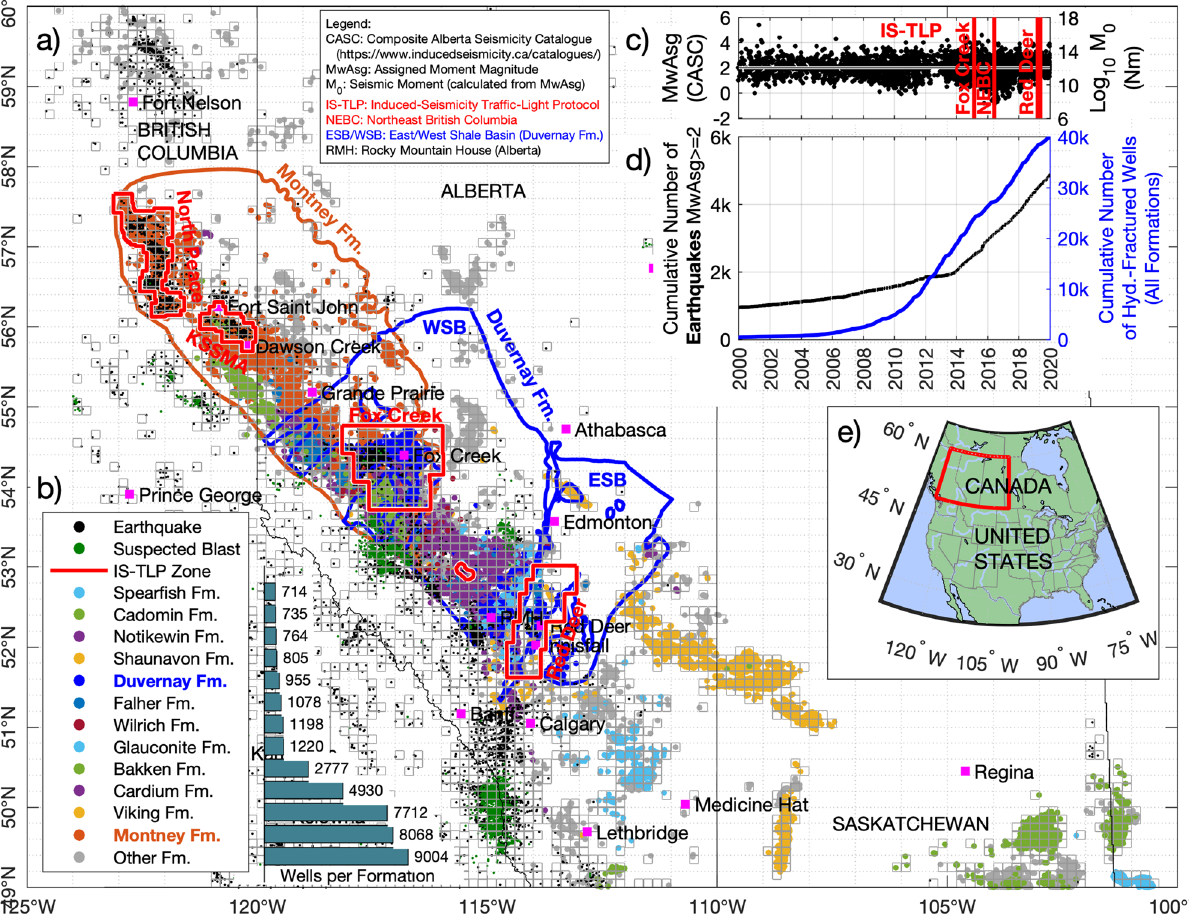
Figure 1. Hydraulically fractured (HF) wells in the Western Canada Sedimentary Basin (WCSB) between January 1, 2000 and January 1, 2020, and the reported seismicity during the same period. The HF wells, colour- coded by the stimulated formation, together with the boundary of the Duvernay and Montney formations, are shown in ( a ), and the number of stimulated wells per formation is shown in ( b ). The moment magnitude